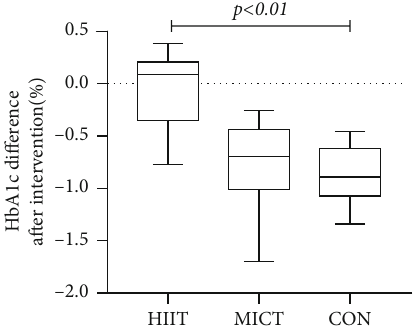
Figure 6: Fasting blood glucose values of each group after intervention.